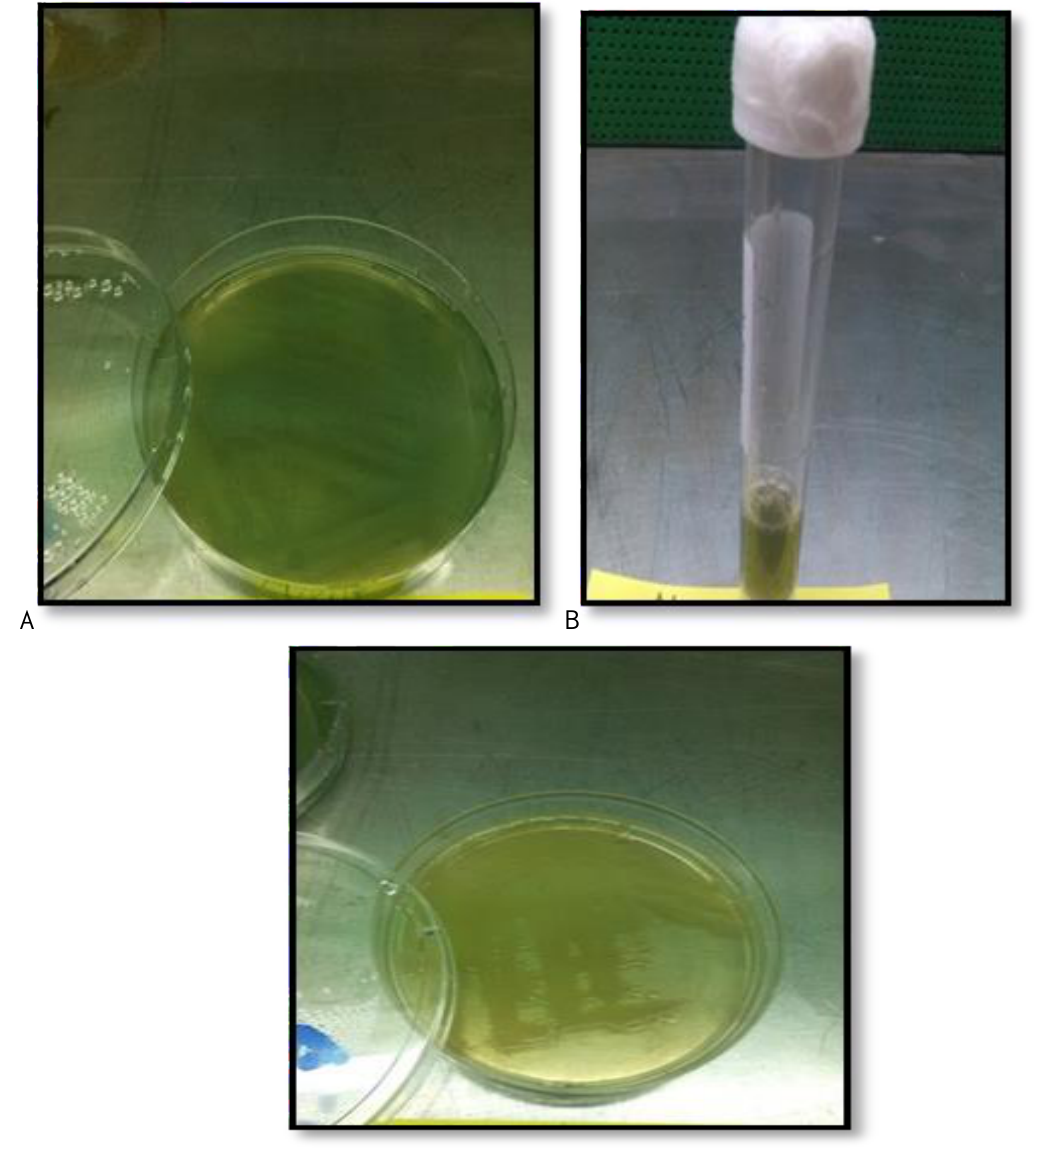
Figure 1 . Growth of P. aeruginosa on: A. Nutrient agar, B. Nutrient broth, C.